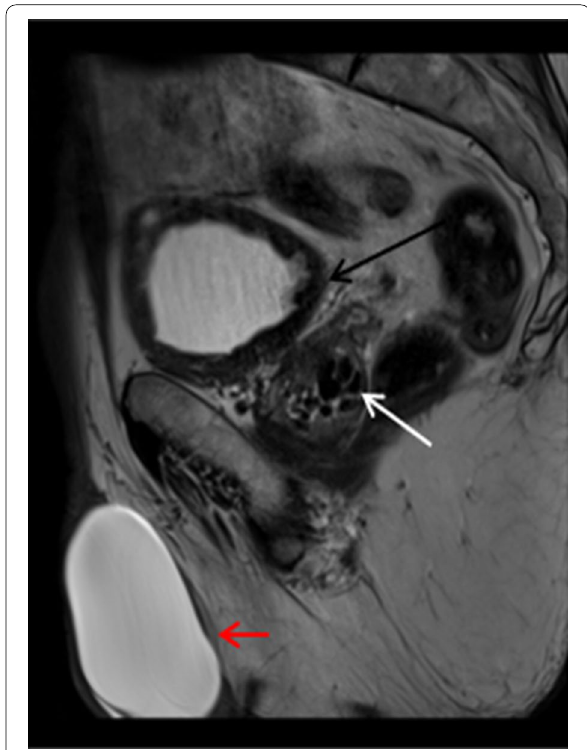
Fig. 16 Sagittal T2W image shows large high T2 signal lesion in the right scrotum in keeping with a hydrocele (red arrow), thickened bladder wall which is low T2 signal is in keeping with a trabeculated bladder wall with debris (black arrow). Low T2 signal lesions seen in the prostate (white arrow) represent prostate calcifications as discussed previously in Fig. 2